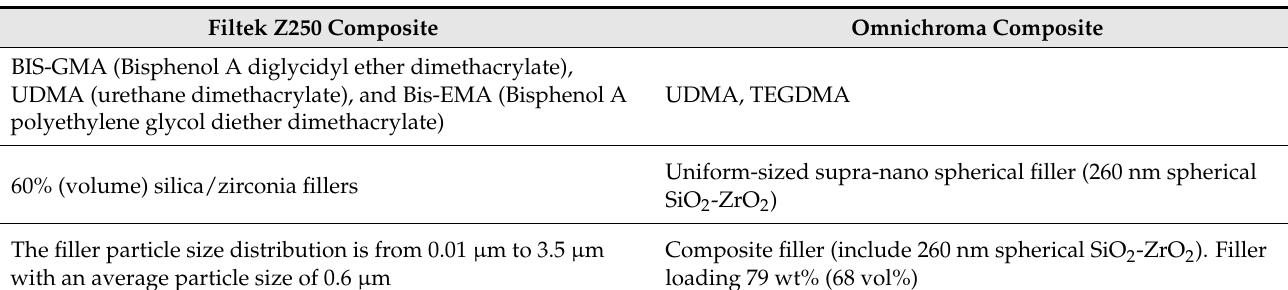
Table 1. Composition of Filtek Z250 and Omnichroma Composites. Figure 1. The dimensions of Class V cavity, ( a ) depth, ( b ) height, ( c ) length. Filtek Z250 Composite